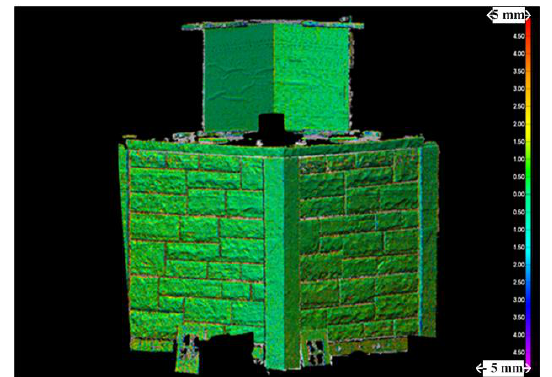
Figure 7. Colour-coded map delivered by inter-comparison and starting from the